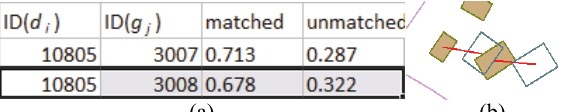
Figure 7: Probability table for case C (a) and the result after domain knowledge is considered